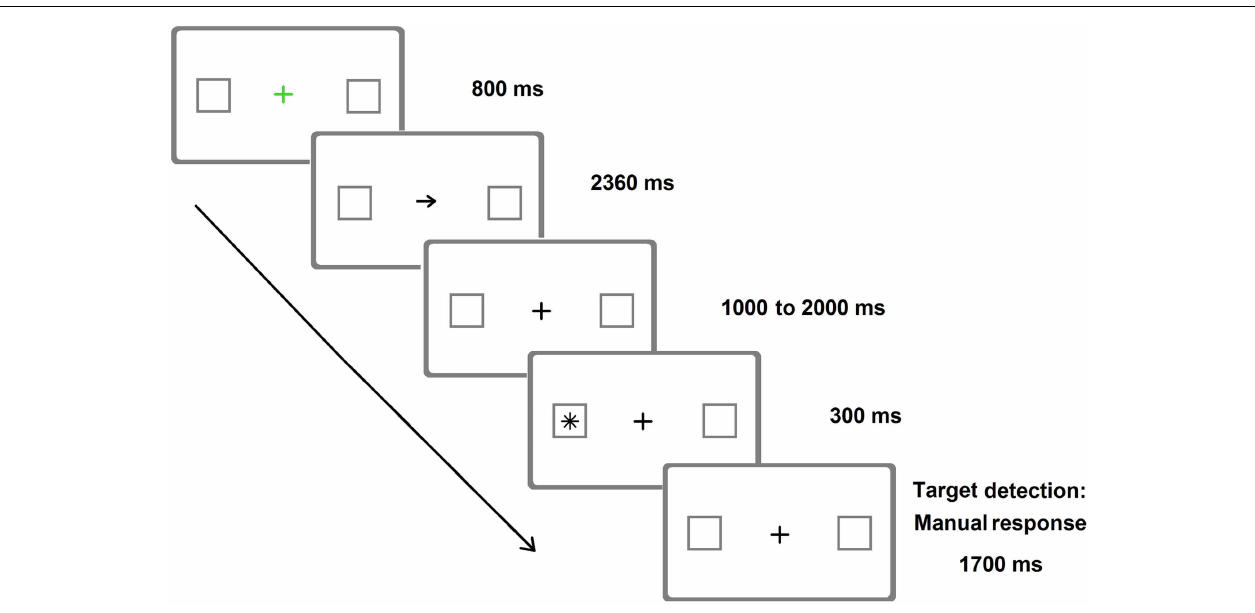
FIGURE 2 | Representative frames of one (invalid) trial of the Posner Cueing Paradigm resembling the version adopted by Rengachary et al. (2009). Arrows predicted the location of appearance of the target on 75% of the trials.The image is only indicative of the stimuli adopted and is not to scale.